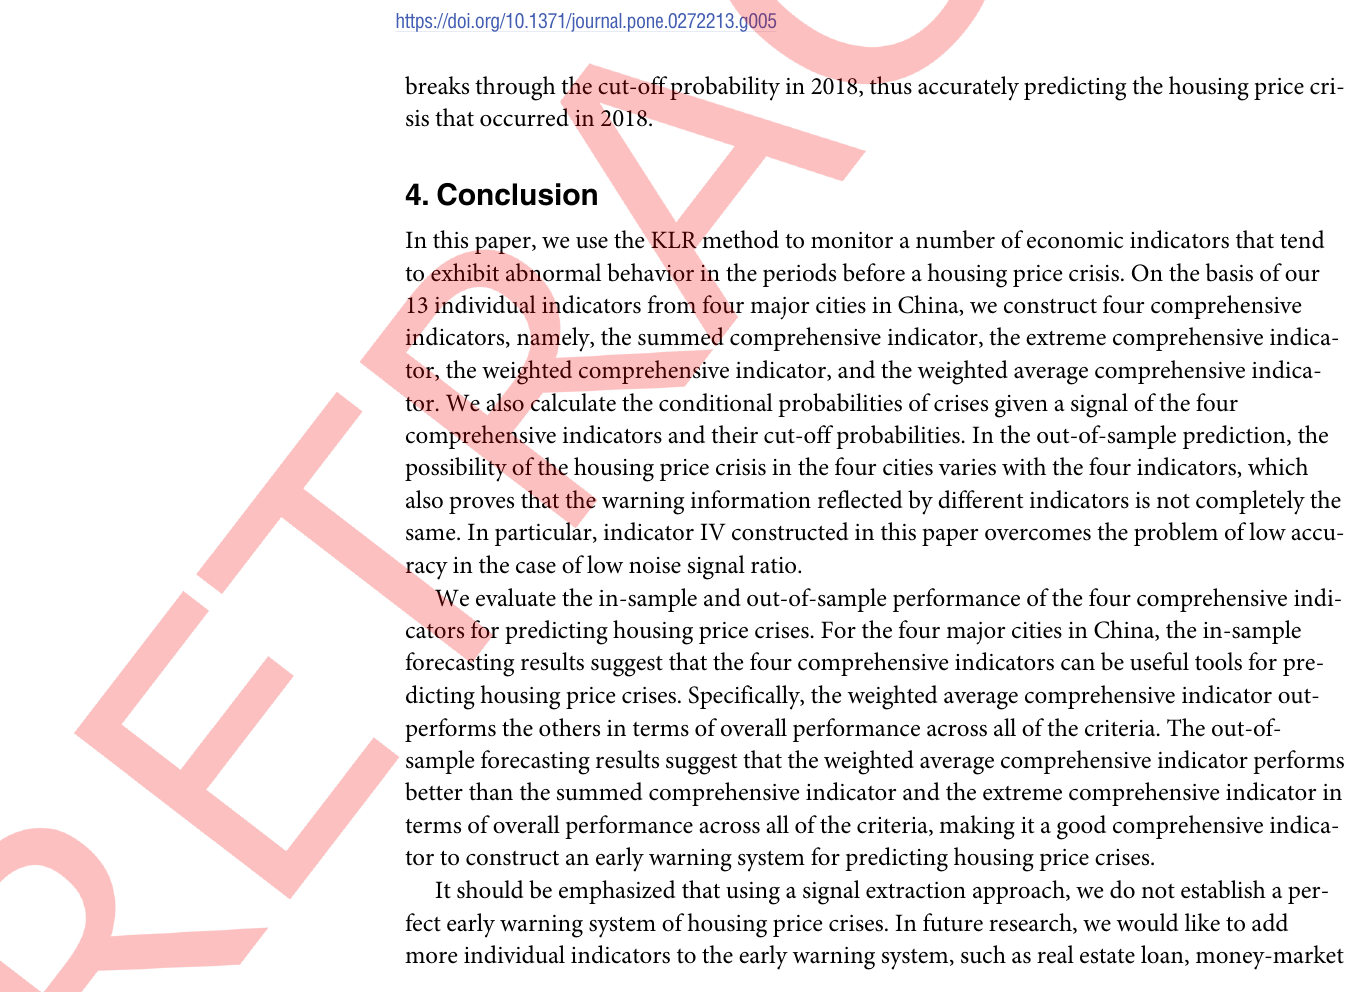
Fig 5. Probability forecasts of housing price crises for Chongqing. The shaded regions represent the time spans of housing price crises. The solid lines are the forecasted probabilities from the four comprehensive indicators with the threshold level of k = 1. Correspondingly, the dashed lines are their cut-off